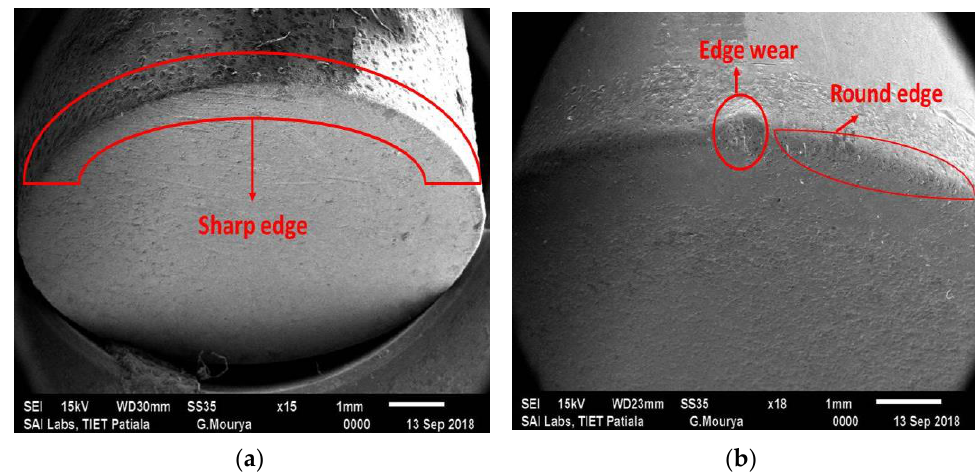
Figure 1. ( a ) SEM of the tool tip before EDM; ( b ) SEM of the tool tip after EDM.